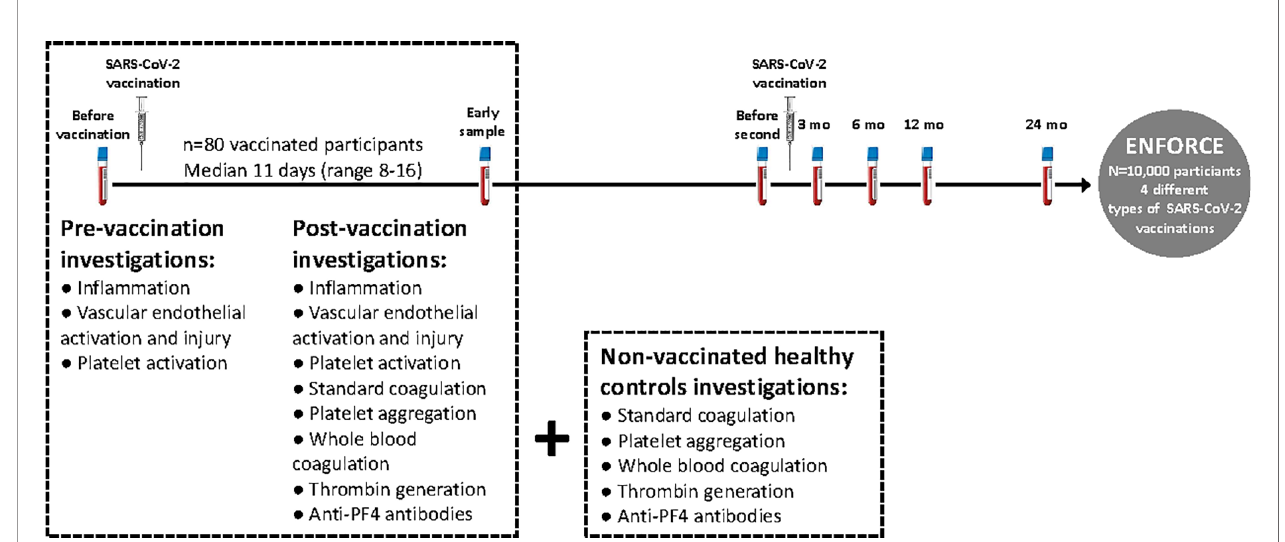
FIGURE 1 | Study design. Eighty participants (n=80) included in the Danish national vaccine trial ENFORCE, recently vaccinated with AZ or mRNA vaccines against COVID-19 were invited to provide an early blood sample post-vaccination (median of 11 days (range 8-16) post-vaccination). Pre-vaccination samples were available from all participants via the ENFORCE study. Since standard coagulation tests, platelet aggregation, whole blood coagulation (Thromboelastometry) and thrombin generation were not available at the pre-vaccination sample, non-vaccinated age and gender matched healthy individuals were invited to participate as